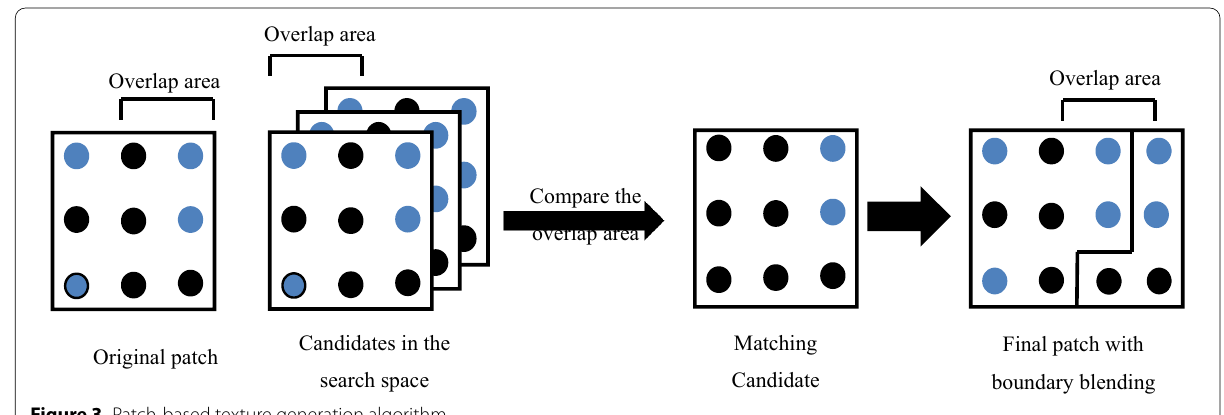
Figure 3 Patch-based texture generation